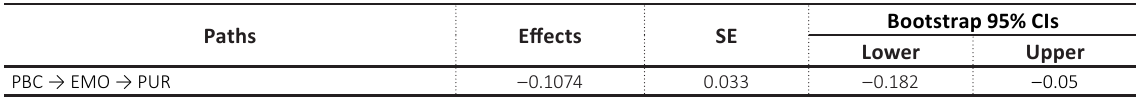
Table 6. Moderation effects of PBC Paths Effects